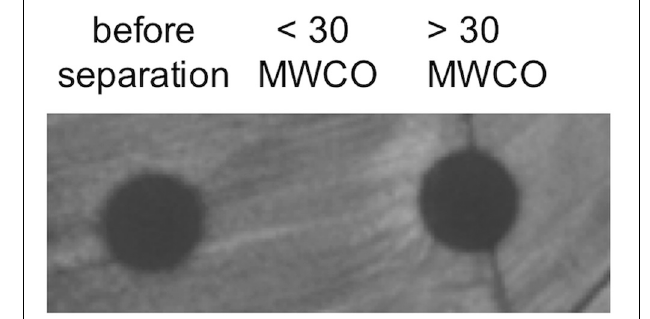
FIGURE 6 | Localization and stability of MV-associated bacteriocins. A protease accessibility assay was used to evaluate the localization of bacteriocin. MVs were treated with trypsin or proteinase K and then evaluated by spot-on-lawn assay.